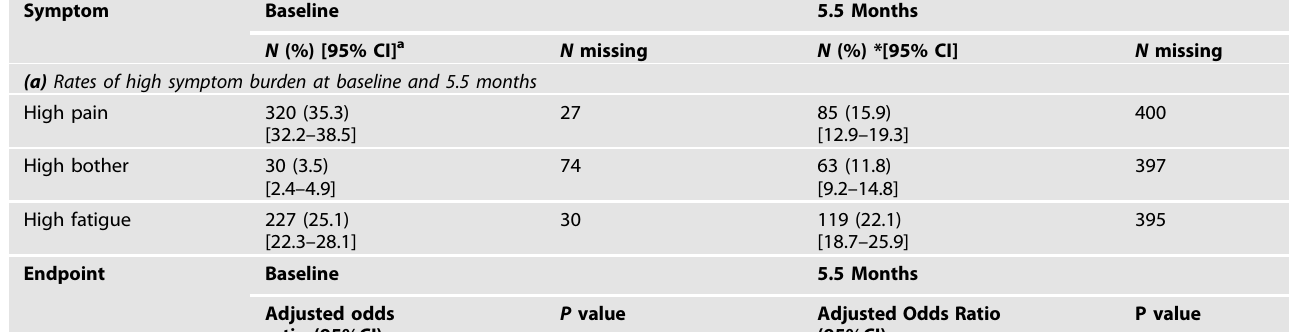
Table 2. a Rates of high symptom burden at baseline and 5.5 months. b Summary of effects of AL and nSES on symptom burden at baseline and 5.5 months.